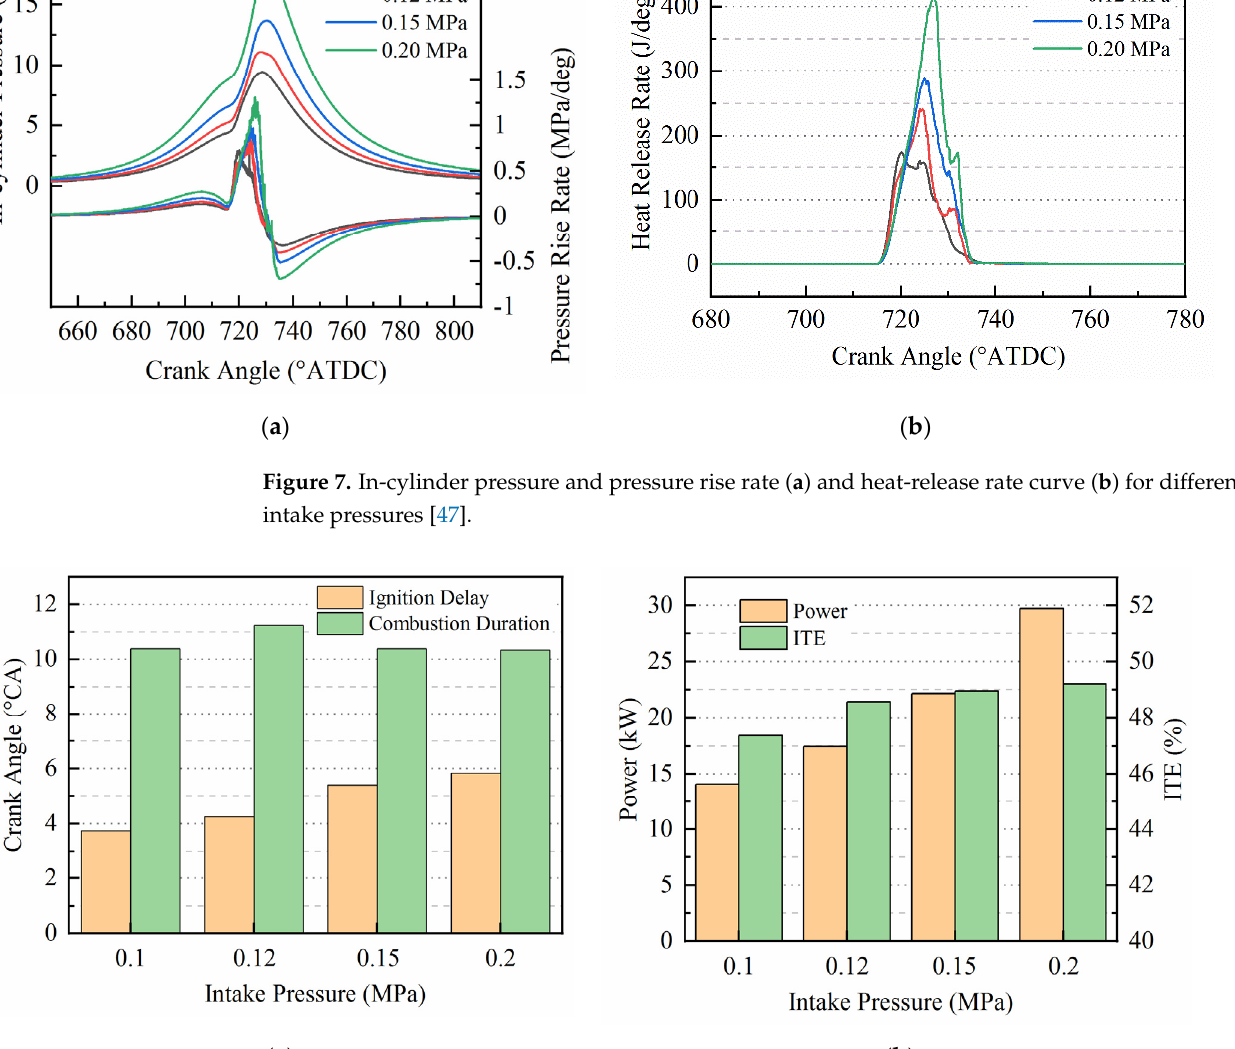
Figure 8. Ignition delay and combustion duration ( a ) and indicated power and ITE ( b ) for different intake pressures [48].